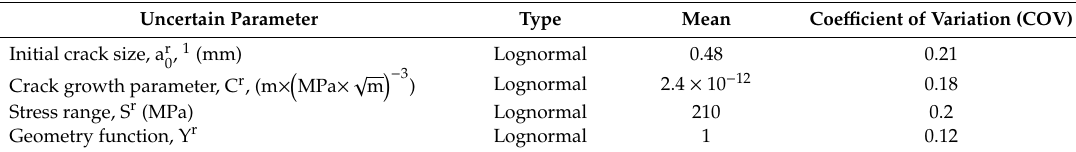
Table 4. Simulated reality distributions for the uncertain parameters